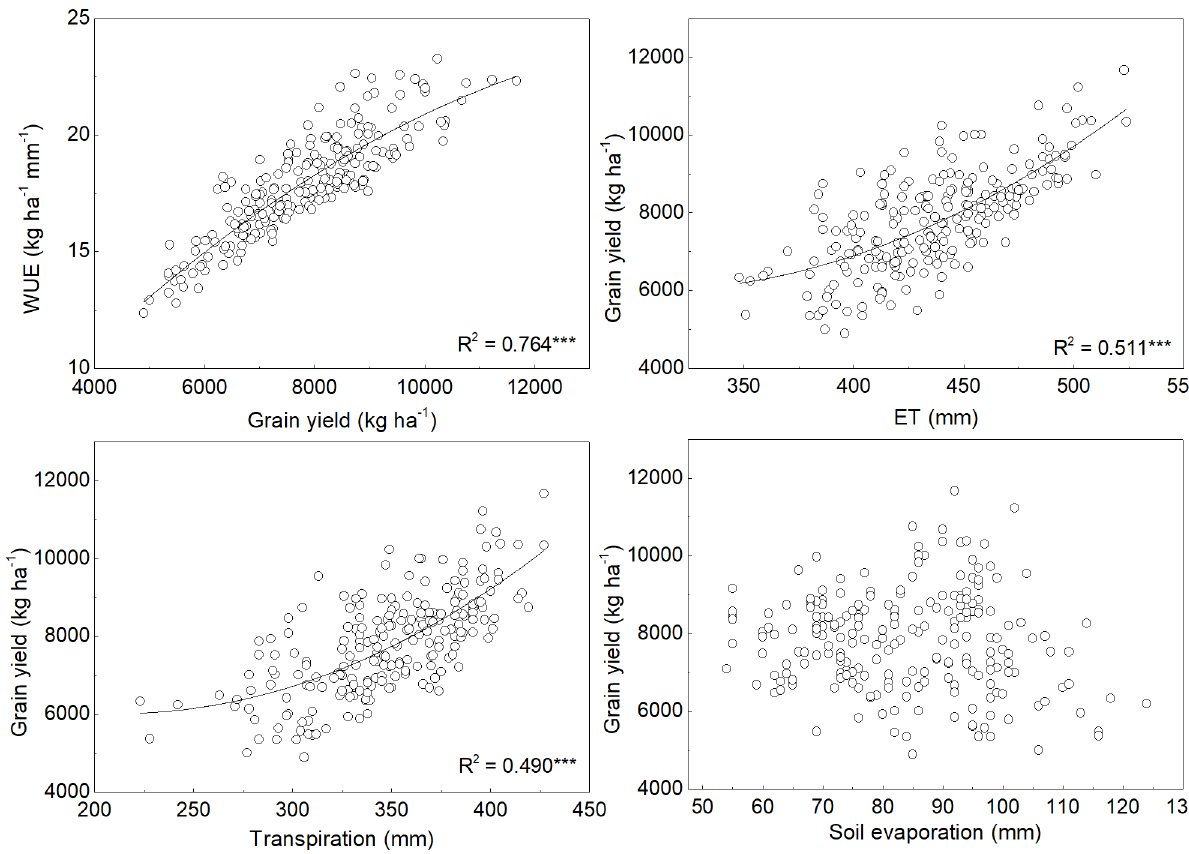
Fig 6. Grain yield response to evapotranspiration (ET) and transpiration and soil evaporation over 22 years. https://doi.org/10.1371/journal.pone.0189989.g006 return increased, but the relative marginal net return and net water use decreased. The maxi- mum relative marginal net return was 13.77 $ ha -1 mm -1 . Take the maximum relative marginal net return as the standard rate, a range of water price rate was set out. So the cost of water was the sum of water power cost and water price rate which is the percentage of the maximum rela- tive marginal net return. The marginal net return in response to water price rate was shown in Fig 8 under different irrigation strategies. The marginal net return was reduced as the rate of irrigation water price increased. The slope of farmer irrigation was higher than others, because